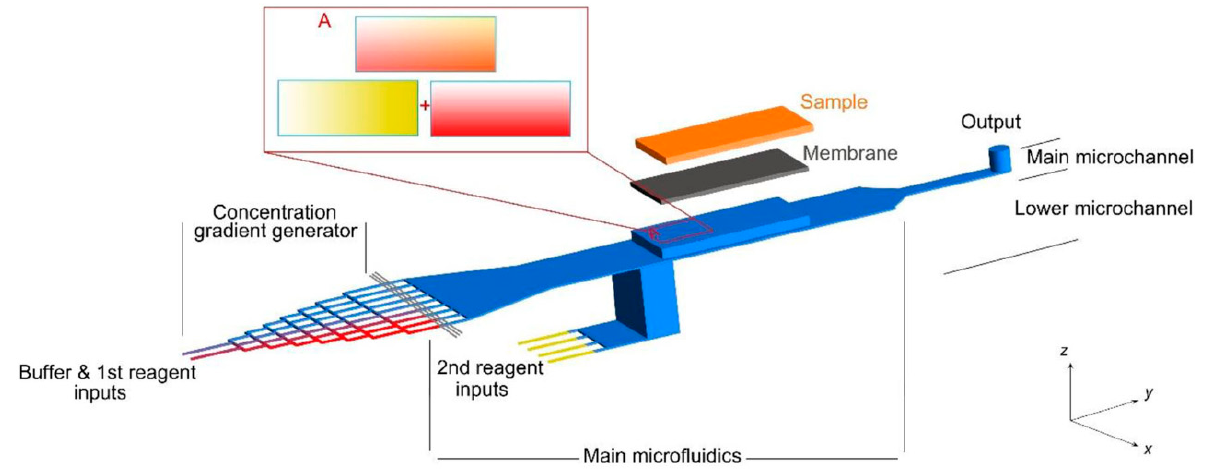
Figure 4. A microfluidic platform for delivering continuous concentration gradients of two different reagents on a tissue sample simultaneously. Reproduced with permission from Ref. [76].